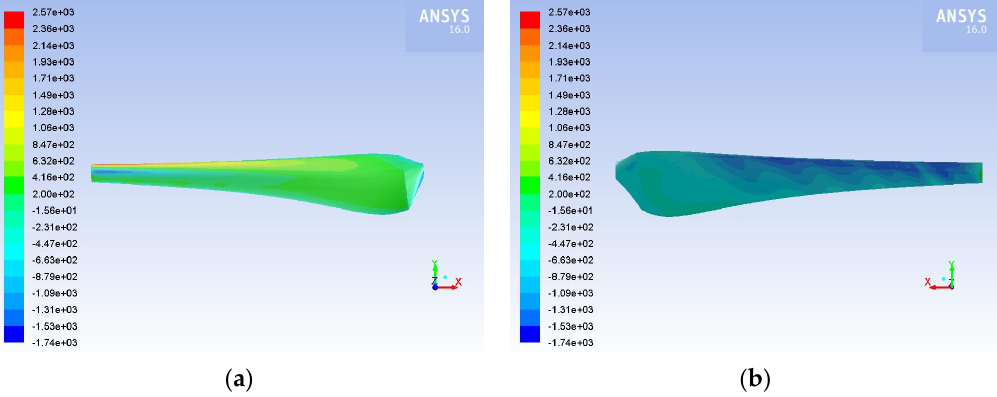
Figure 12. Contours of pressure on ( a ) the pressure; ( b ) the suction side of the blade for hailstorm conditions and air velocity equal to 15 m·s − 1 .